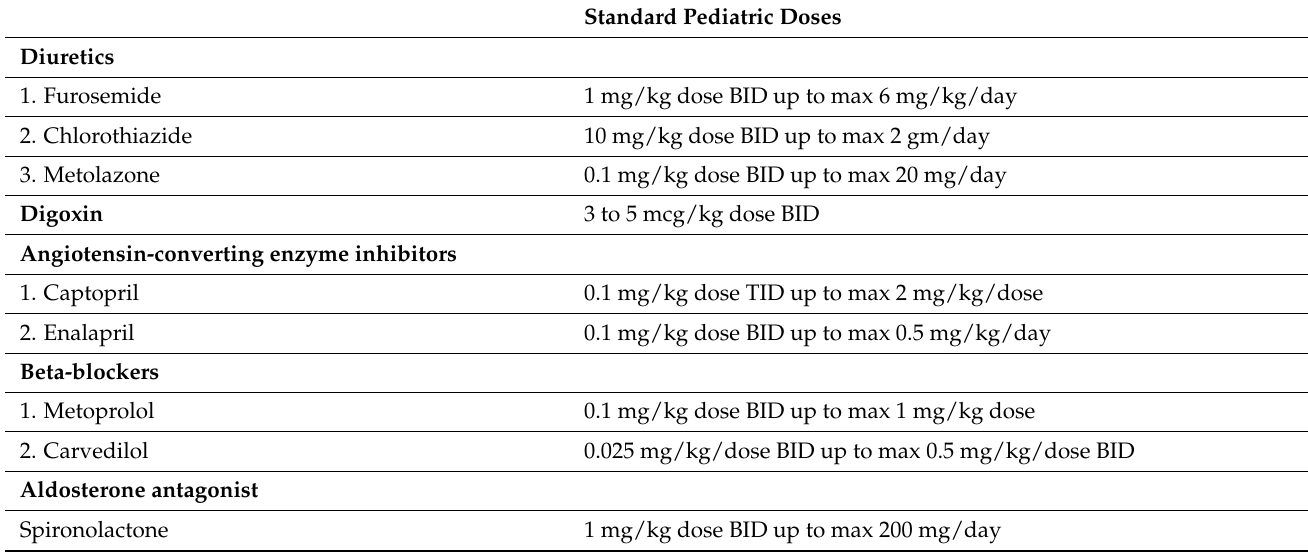
Table 2. Summary of commonly used pediatric HF drugs and